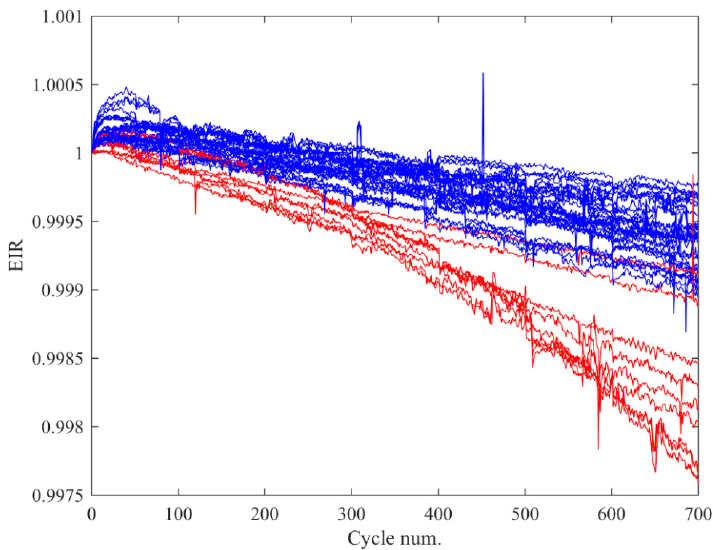
Figure 7. EIR of selected battery samples.